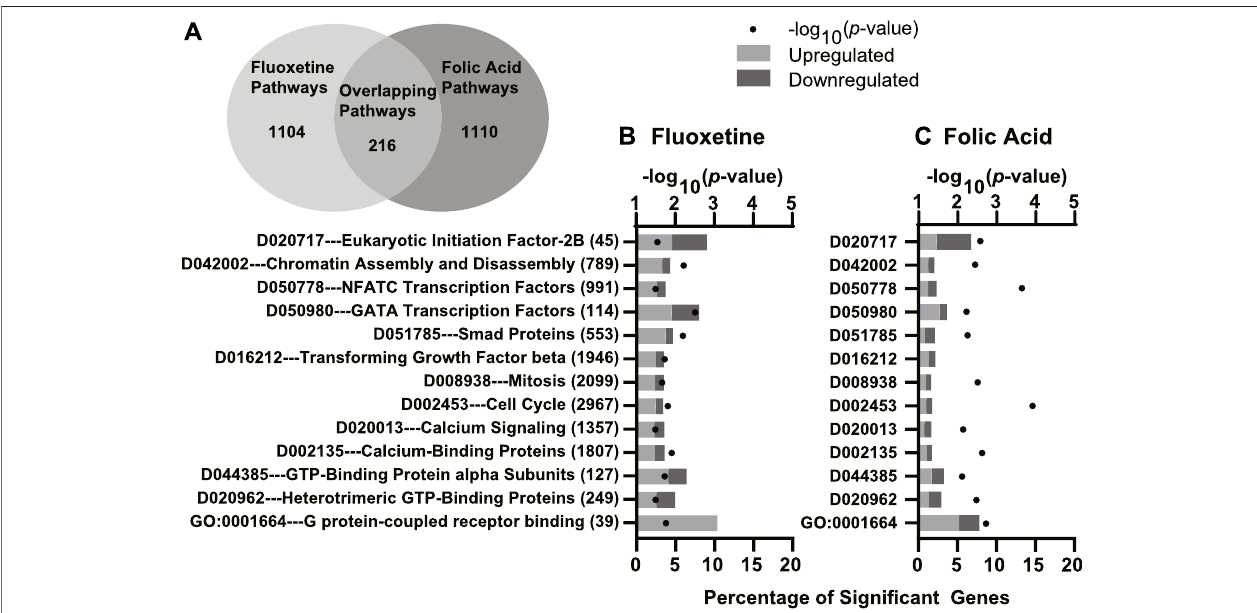
FIGURE 6 | Signi fi cantly enriched Gene Ontology (GO), Kyoto Encyclopedia of Genes and Genomes (KEGG), and Medical Subject headings (MeSH) pathways simultaneously enriched in both comparisons for fl uoxetine treatment and folic acid (FA) supplementation. There were 216 overlapping pathways between the two comparisons (A) . GO, KEGG, and MeSH enriched pathways inthemammaryglandsofmice treatedwith fl uoxetine (20 mg/kg/d)compared tosaline control (B) and FA supplementation (24 mg/kgFAdiet)comparedtocontrol(4 mg/kgFAdiet) (C) .They-axisdenotesthenamesandtotalnumberofgenesineachpathway, andthe lower x-axis denotes the percentage of signi fi cant genes within each pathway. The upper x-axis denotes the − log 10 p -value. Light gray bars indicate upregulated DEGs and dark gray bars indicate downregulated DEGs within each